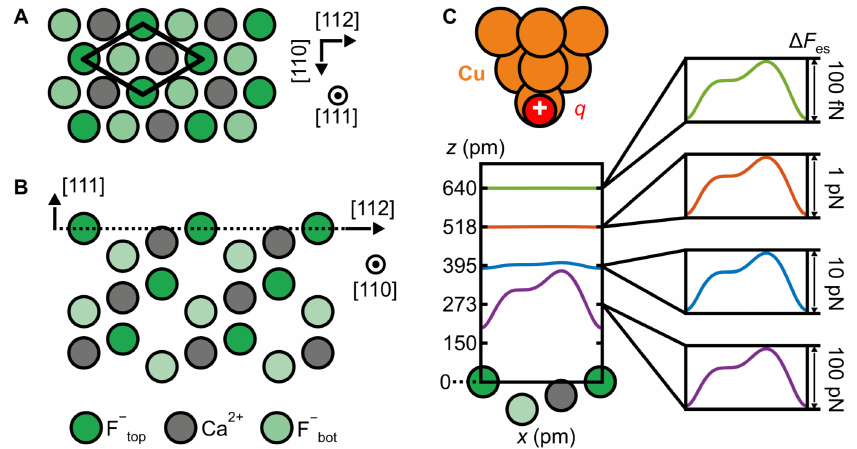
Figure 10. Schematic of the CaF 2 (111) surface and decay of the short-range electrostatic tip–sample interaction with distance. ( A ) Top view of the CaF 2 (111) surface. The surface unit cell presents three inequivalent sites, corresponding to the different ions of the topmost triple layer [50]. ( B ) Side view of the CaF 2 (111) surface. The surface layer is marked by the dashed line. ( C ) A single-atom metal tip has been modeled with a positive point charge q . Graph: illustration of the exponential decay of the short-range electrostatic force contrast ∆ F es with tip–sample distance z for the single-atom metal tip above the CaF 2 (111) surface. Adapted with permission from Institute of Physics from Figure 1 in